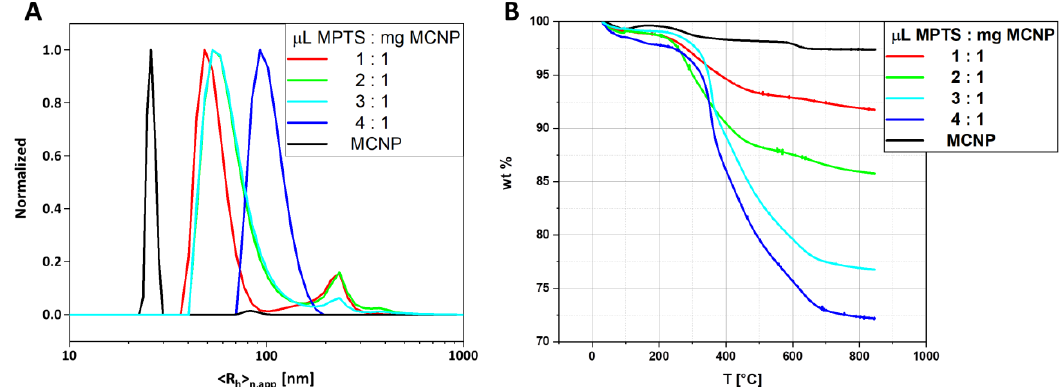
Figure 1. ( A ) Number-weighted DLS CONTIN plots of pristine MCNP (black line, (cid:104) R h (cid:105) n,app = 26 nm), and MPTS@MCNP obtained for varying ratios of MPTS to MCNP of 1:1 (red line, (cid:104) R h (cid:105) n,app = 48 nm), 2:1 (green line, (cid:104) R h (cid:105) n,app = 53 nm), 3:1 (cyan line, (cid:104) R h (cid:105) n,app = 52 nm), 4:1 (blue line, (cid:104) R h (cid:105) n,app = 93 nm). ( B ) Thermograms of MCNP (black line, 2.6% overall weight loss), MPTS@MCNP obtained from a ratio of MPTS to MCNP of 1:1 (red line, 8.2% overall weight loss), 2:1 (green line, 14.2% overall weight loss), 3:1 (cyan line, 23.2% overall weight loss), 4:1 (blue line, 27.8% overall weight loss).